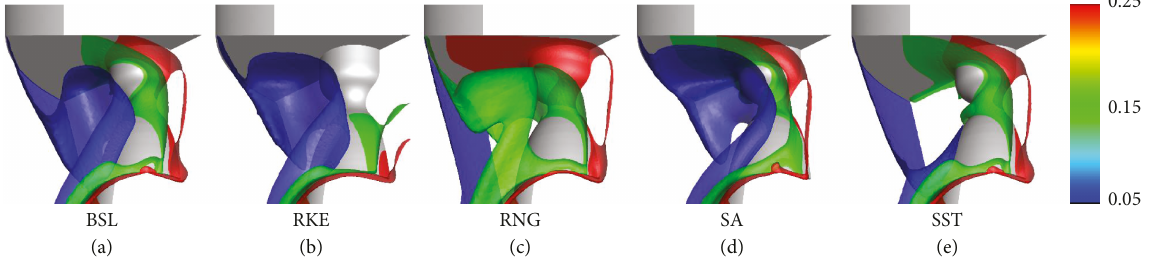
Figure 10: Isosurfaces of CO